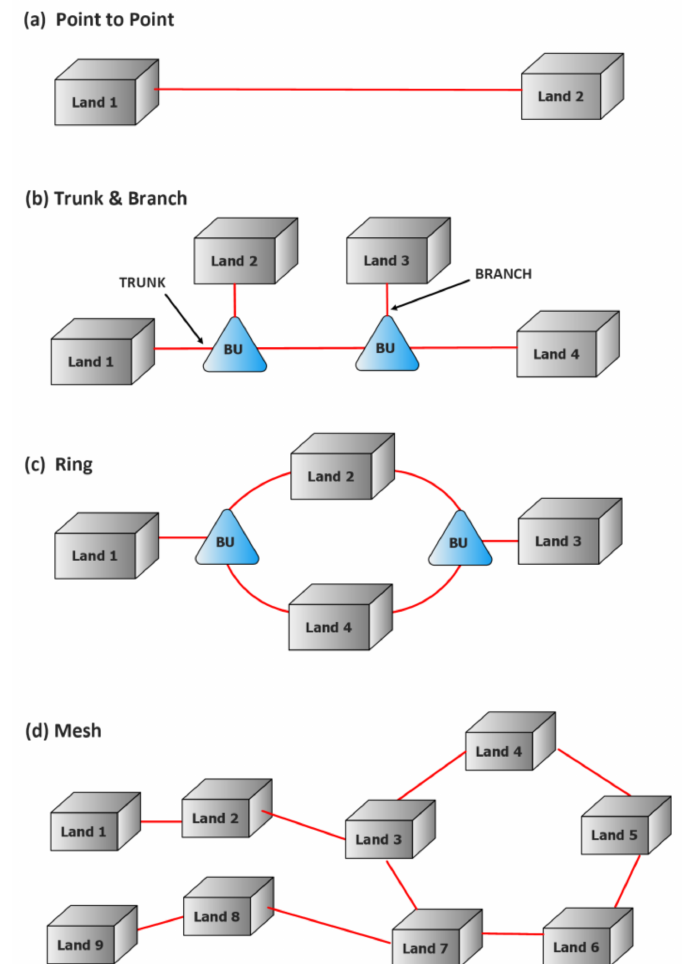
Figure 28. Underwater connecting options. ( a ) Point to Point topology. ( b ) Trunk and Branch topology. ( c ) Ring topology. ( d ) Mesh